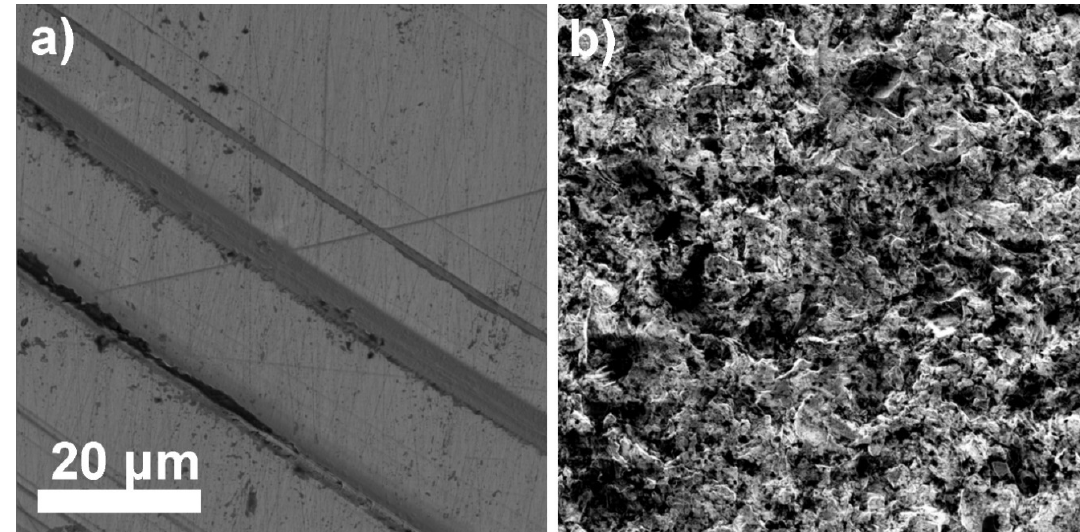
Figure 8. LaF 3 single-crystal membrane (with diameter of 8.0 mm and thickness of 1.0 mm, doped with 1.0% Eu) surface at 10,000× magnification ( a ) before Fe x O y NPs loading and ( b ) after leaching out some Fe x O y NPs.